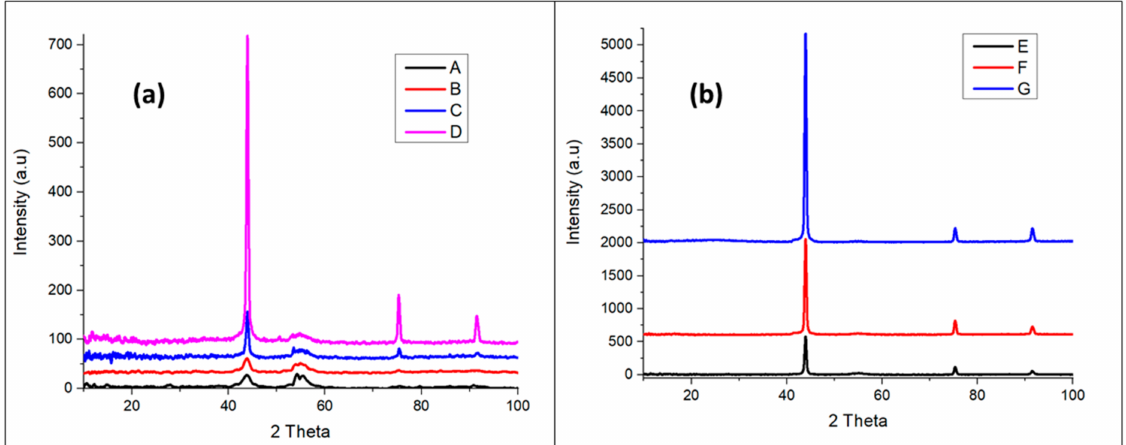
Figure 2. X-ray diffraction (XRD) spectra from PCD films grown with different grain sizes. ( a ) Samples A–D grown for 2 h with different Ar:H gas mixtures. ( b ) Samples E–G grown with H (no Ar) gas flow for different deposition time (Table 1).